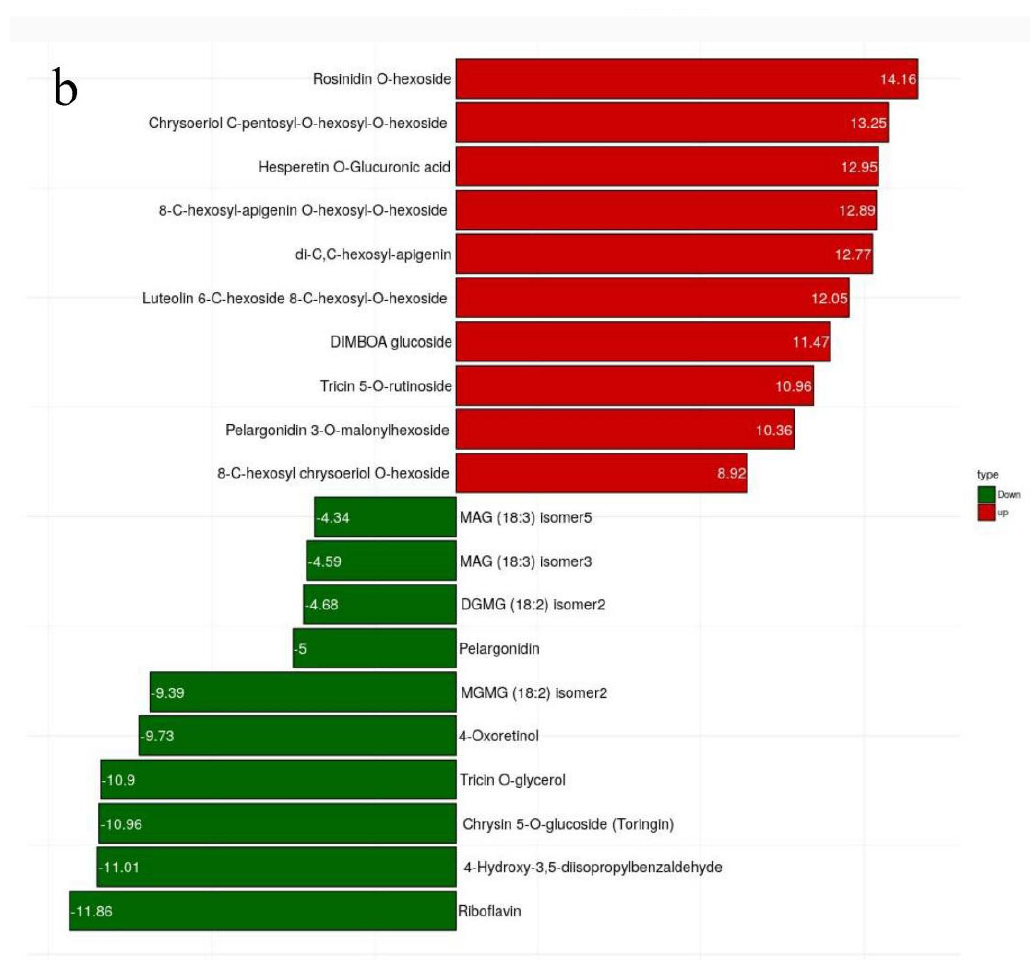
Figure 2. Metabolome of mature pericarp of B214 and B227: ( a ) KEGG enrichment of DAMs in mature pericarp of B214 and B227. X -axis represents rich factor of each pathway and y -axis represents the names of pathways. Color of bubbles indicates the p -value, the redder, the more significant. Size of bubbles indicates the number of metabolites included in the pathway. ( b ) Representatives of 10 most up-accumulated and 10 most down-accumulated metabolites in B214. X -axis rep- resents the value of Log2FoldChange (B214/B227) and y -axis represents the index of metabolites (Table S1).